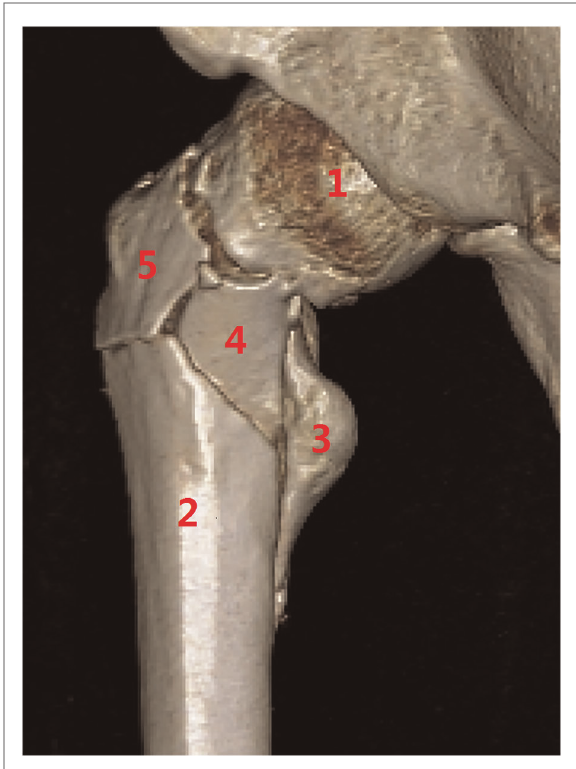
FIGURE 13 Subtype A4.2, with further comminution of the intracapsular calcar cortex. (1) Head – neck fragment; (2) femoral shaft; (3) lesser trochanter; (4) medial calcar fragment; and (5) anterior wall fragment.